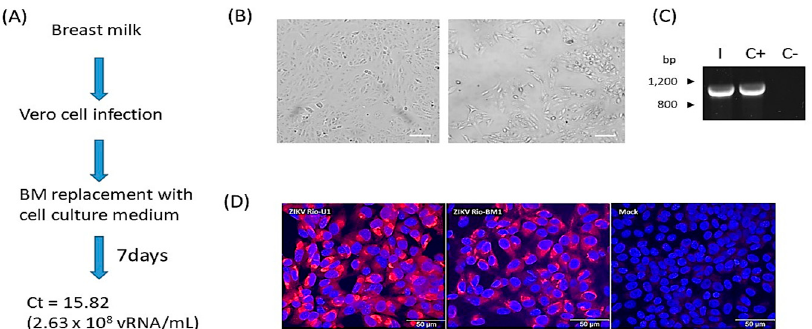
Figure 1. Isolation of ZIKV from the breast milk in Vero cells. ( A ) Experimental design of the isolation of ZIKV from breast milk showing ( B ) the occurrence of CPE after seven days post-infection. Scale bar, 25 µ m ( C ) Viral RNA detection in the cell supernatant using RT-PCR/RT-qPCR at seven days post-infection. ( D ) Recognition of ZIKV antigens in Vero cells infected with the ZIKV isolate Rio-BM1. After 72 h of infection, Vero cells were immunostained with the pan-flavivirus monoclonal antibody 4 G2 (red) and counterstained with DAPI (blue). As control conditions, cells were infected with ZIKV isolate Rio-U1 and